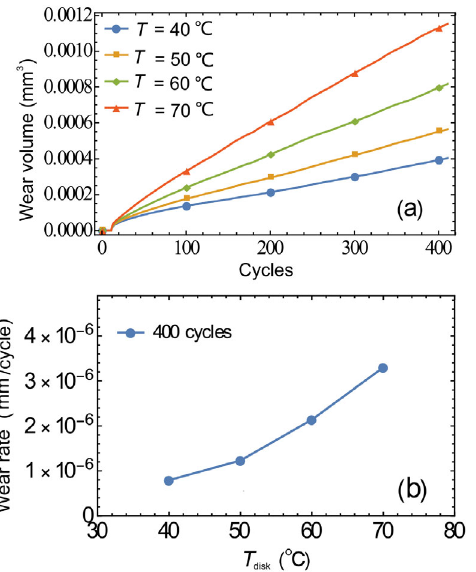
Fig. 17 Wear volume evolution comparison of the experiment and the two models (Archard and